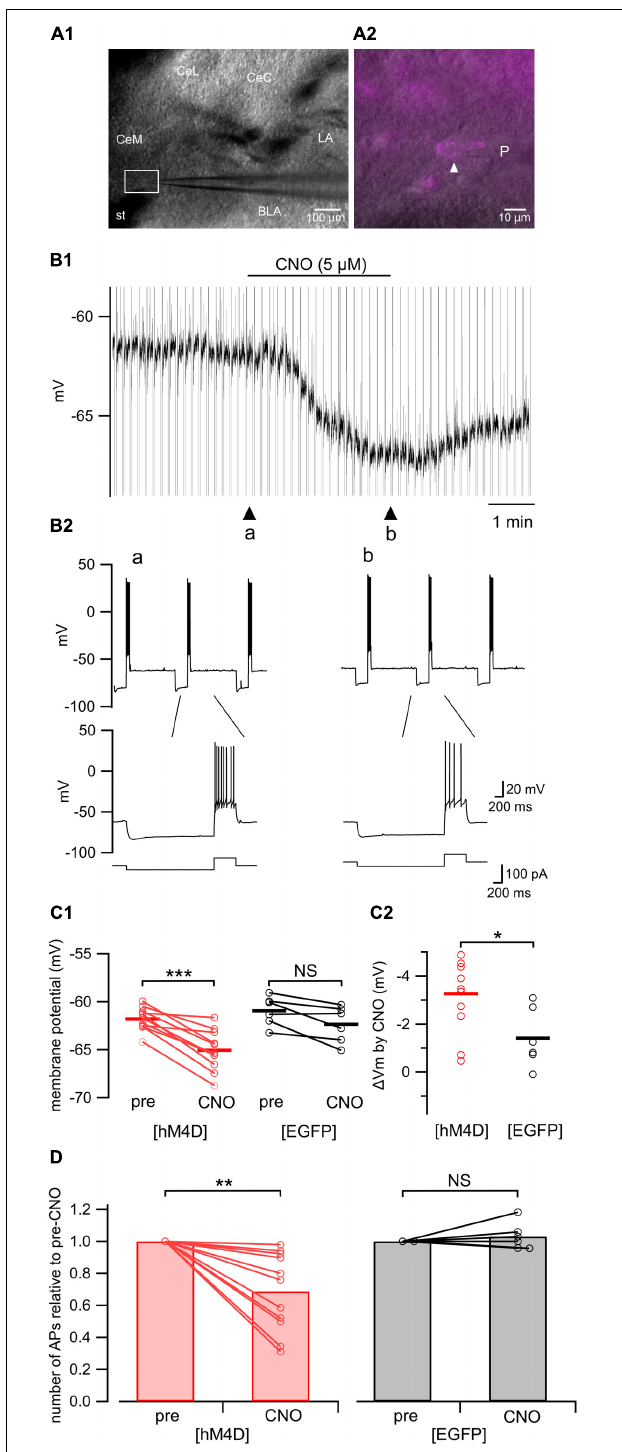
FIGURE 5 | Electrophysiological recordings from hM4D(G i )-mCherry-expressing amygdala neurons in acute slices. (A1) A representative microphotograph of the coronal amygdala slice used for patch-clamp recording. CeM, medial subdivision of the central amygdala; CeL, lateral subdivision of the central amygdala; CeC, capsular subdivision of